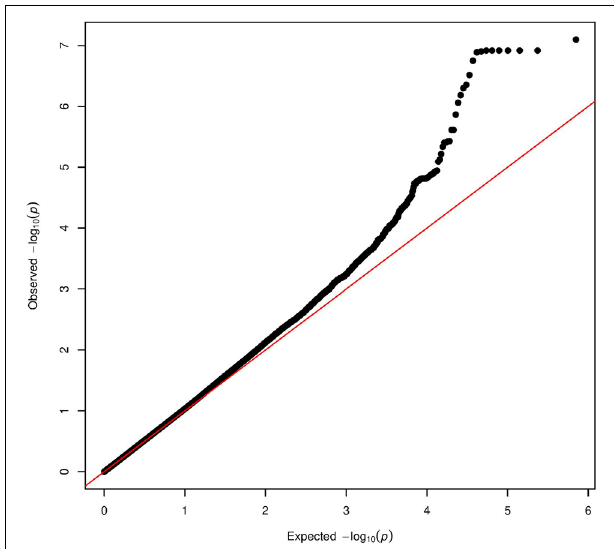
FIGURE 2 | Quantile-quantile plot of the association analysis with LTL in the ERF study. The QQ-plot shows the observed test statistics ( y -axis) plotted against the expected values of the test statistics ( x -axis) (X 2 -distribution). The red line shows the distribution under the null